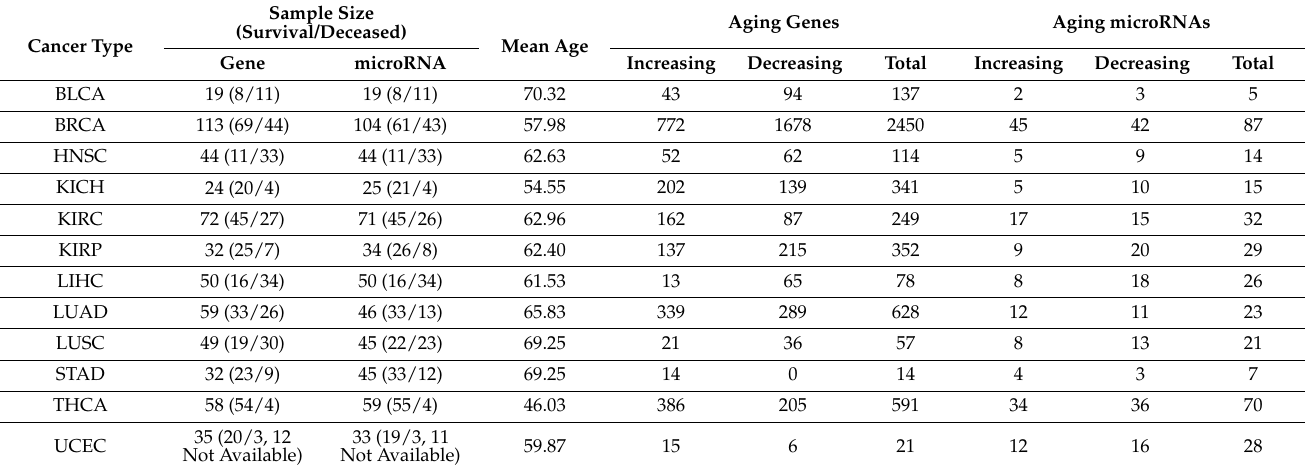
Table 1. Demographics and the number of identified aging-related genes and